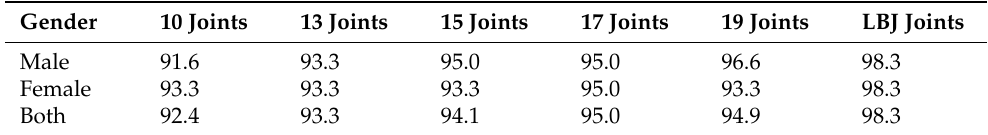
Table 8. Classification accuracy of the proposed system with different set of